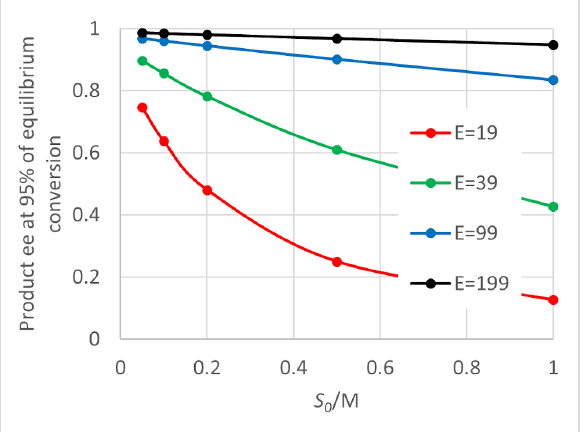
Figure 2: Effect of the initial starting material concentration and en- zyme E value for “ordered, second” kinetics. D = 0.00333 M, Q = 0.00167 M, K eq = 5, E = 39, K MD = 0.001 M, K MS = 0.001 M, k 4 = 1000 s − 1 , SCRf / b = 1, k 3R / k 4 = 1, k 3R / (E · k 3S ) = 1, k − 4 / k 1 = 1, k − 2R / k − 1 = 1, E · k − 2S / k − 1 = 1.